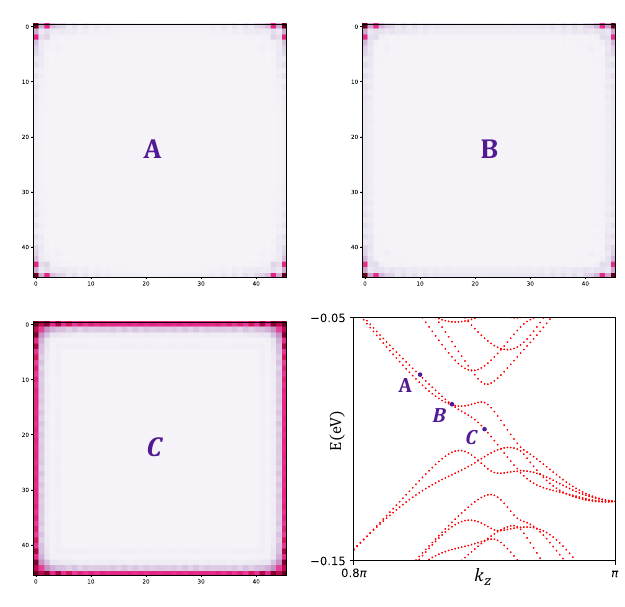
Figure 3: Spread of wavefunctions of the hinge bands on the cross section of the 46x46 ( 100 ) wire , marked A-C. As can be seen, away from the surface gap, the wavefunctions are localized in the corners of the wire. Close the gapped Dirac cone, the wavefunction is spread across the two dimensional surfaces of the